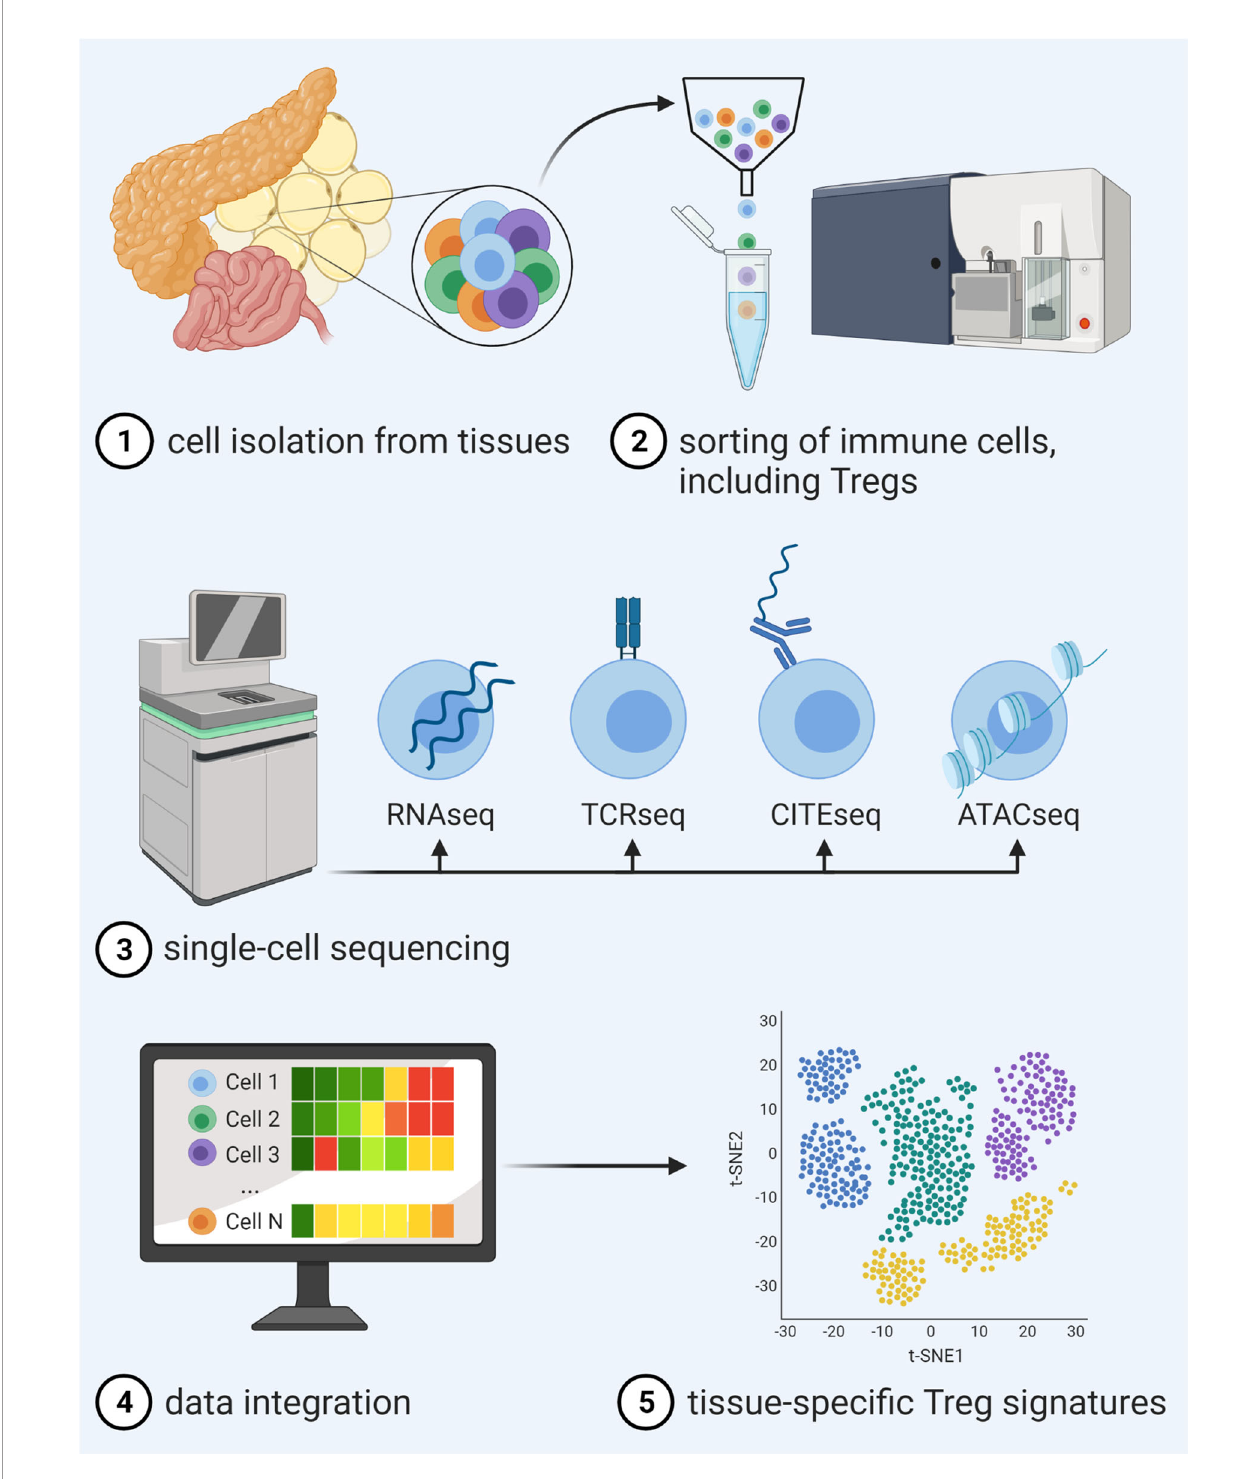
FIGURE 1 | Advancements in single-cell multi-omics integration allow for a detailed analysis of tissue Treg signatures. After isolation and sorting of heterogeneous immune cell populations from tissues and single-cell sequencing of distinct libraries for RNAseq in combination with, e.g., TCRseq, CITEseq or ATACseq, novel computational approaches enable data integration of different traits, thereby enabling unprecedented description of molecular behavior and identities of individual cells within a certain tissue.